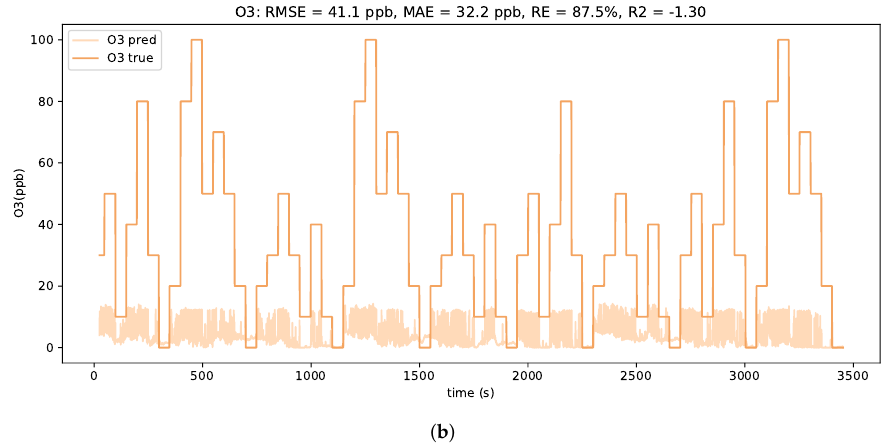
Figure 10. Prediction plots of the LSTM model for two levels of additive downwards drift at ( a ) 50% and ( b ) 225%.